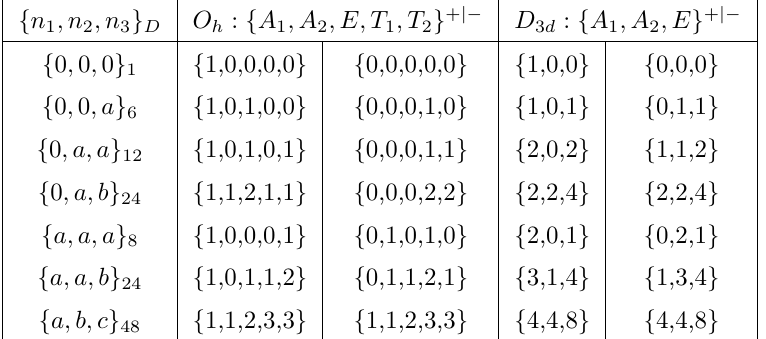
Table 3 . Different patterns for the representation spaces { n 1 , n 2 , n 3 } and the multiplicity of irreps in such patterns for the O h and D 3 d groups. The subscript D denotes the dimension of the rep- resentation space, while a , b and c are different non-zero numbers. The numbers in the last four columns are the multiplicities of the corresponding irreps in different representation spaces.